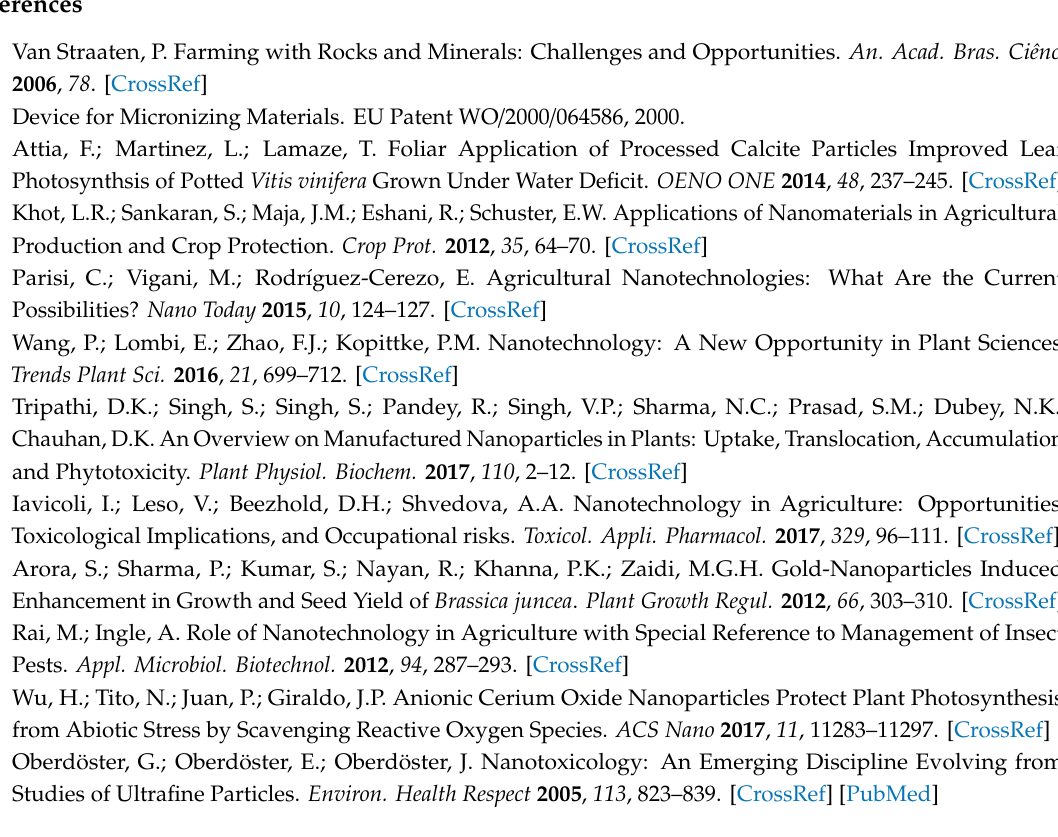
s1. Figure S1. A. Mean values of CaPP-induced CLA luminescence B. Comparison of CaPP- and CaCO 3 -induced ROS generation in free MS medium. Figure S2: A. Kinetic of biological ROS generation detected with